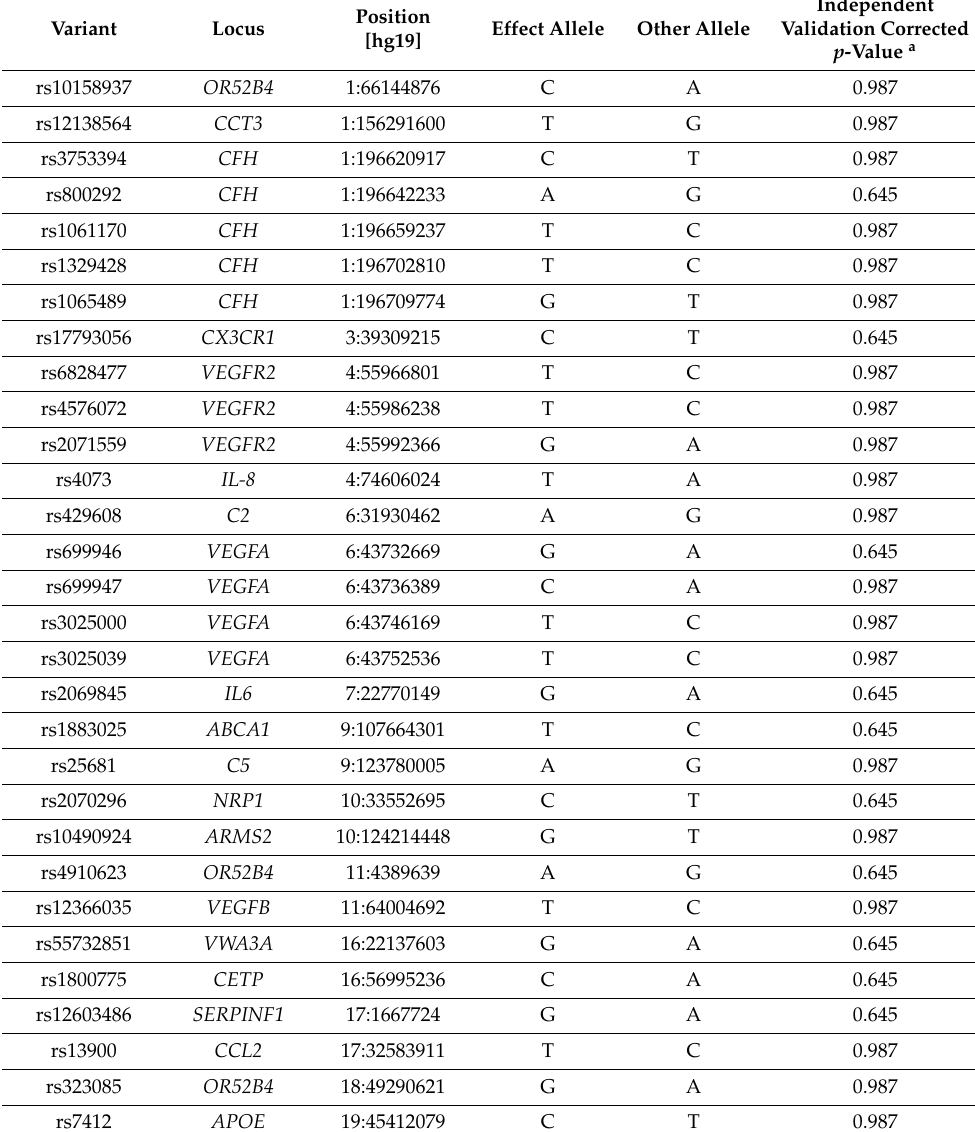
Table 2. Replication of genetic variants previously associated with anti-VEGF treatment response.